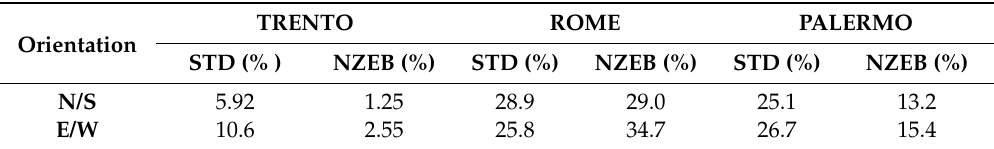
Table 8. Percentage differences between the EBI calculated for RG and BEST, in the cases of the STD and NZEB models at the three